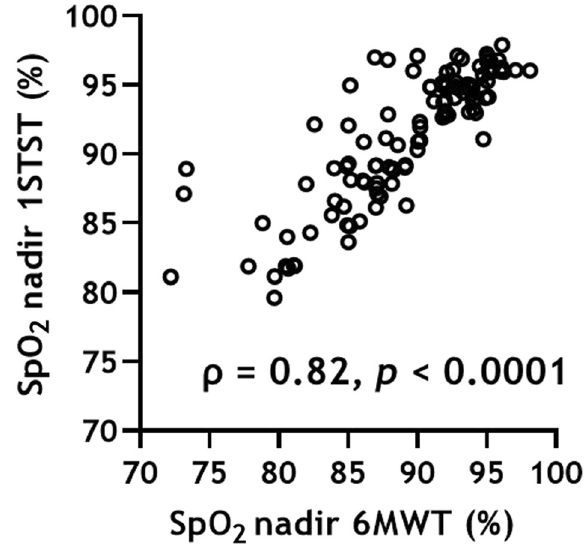
Fig. 1 Correlation between the SpO 2 nadir values during the 6MWT and 1STST. 1STST 1 min sit-to-stand test, 6MWT 6 min walk test, SpO 2 pulse oxygen saturation.